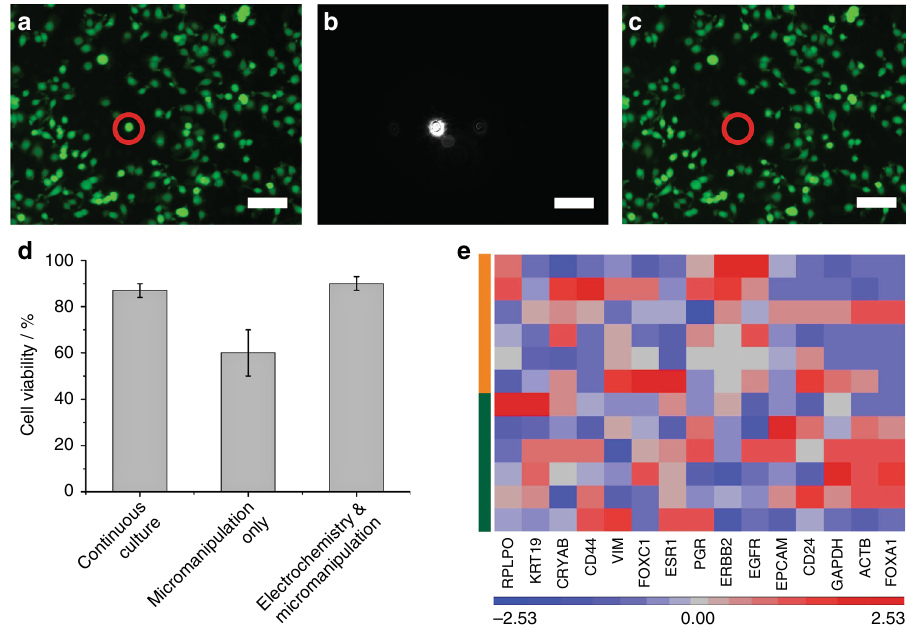
Fig. 3 Localised release of single cells and investigating the release effect on cells. a – c Fluorescence microscopy images of calcein-stained cells (green) before release ( a ); during electrochemical “ cleavable ” reaction to a speci fi c area by illuminating a single cell with a laser ( b ); after release and recovery with a micromanipulator ( c ). Scale bar = 100 µ m. d Cell viabilities of MCF-7 cells in continuous culture that have been left in ambient conditions for 1 h (left column), recovery from an anti-EpCAM-modi fi ed silicon sample using the micromanipulator without electrochemical release (middle column) and recovered from a switchable anti-EpCAM-modi fi ed silicon surface with a microcapillary after electrochemical release of the cells (right column). Error bars represent the margin of errors at 95% con fi dence, n = 6. e The genetic expression of commonly used epithelial cancer biomarkers for six single electrochemically isolated MCF-7 cells (orange) and six single MCF-7 cells obtained by serially diluting the continuous culture followed by recovery with the micromanipulator (green). The degree of upregulation or downregulation relative to the serially diluted MCF-7 cells is represented with a red or blue box,